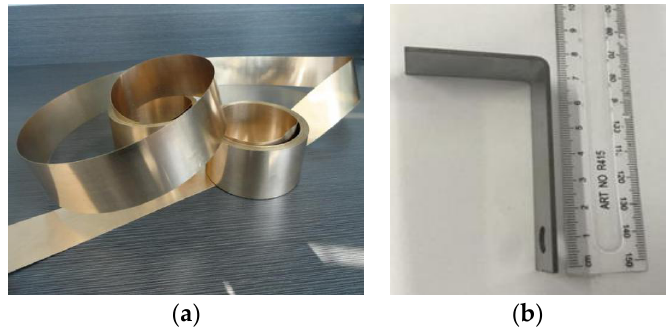
Figure 2. Brazing joint parts: ( a ) BNi-2 foil and ( b ) L-type 304 stainless steel.